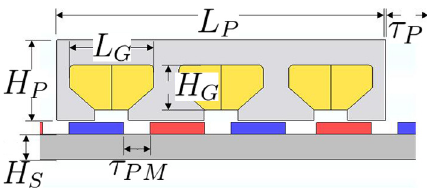
Figure 5. Main dimensions of the